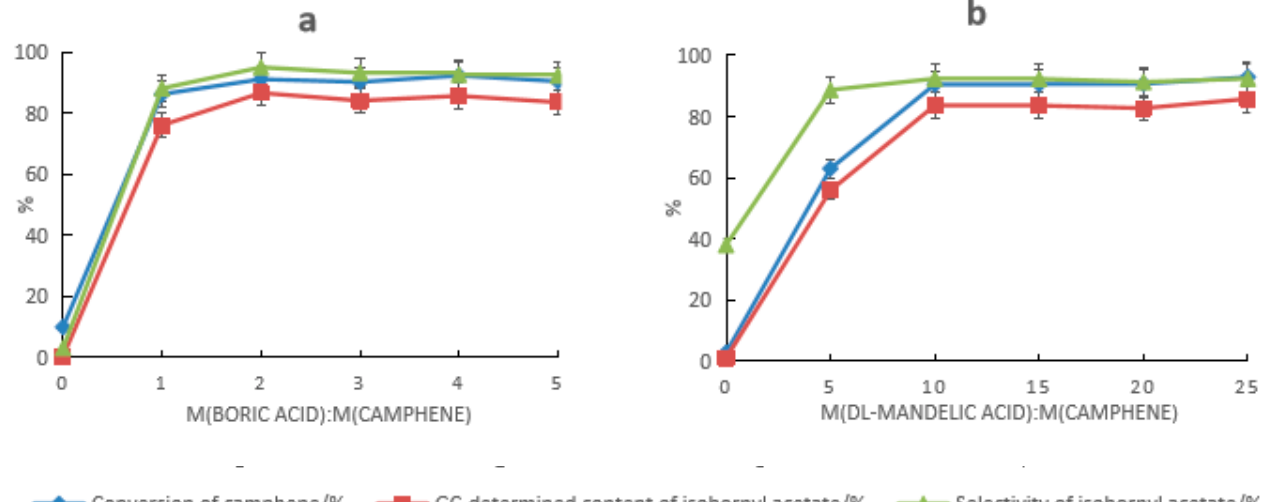
Figure 2. Effect of composition changes in the mandelic acid–boric acid composite catalyst on the catalytic performance. ( a ) Effect of mandelic acid on the catalytic performance under the following reaction conditions: m(camphene):m(acetic acid):m(boric acid) = 10:10:0.5, reaction temperature of 70 °C, and reaction time of 18 h. ( b ) Effect of boric acid on the catalytic performance under the following reaction conditions: m(camphene):m(acetic acid):m(mandelic acid) = 10:25:1, reaction temperature of 70 °C, and reaction time of 18 h.